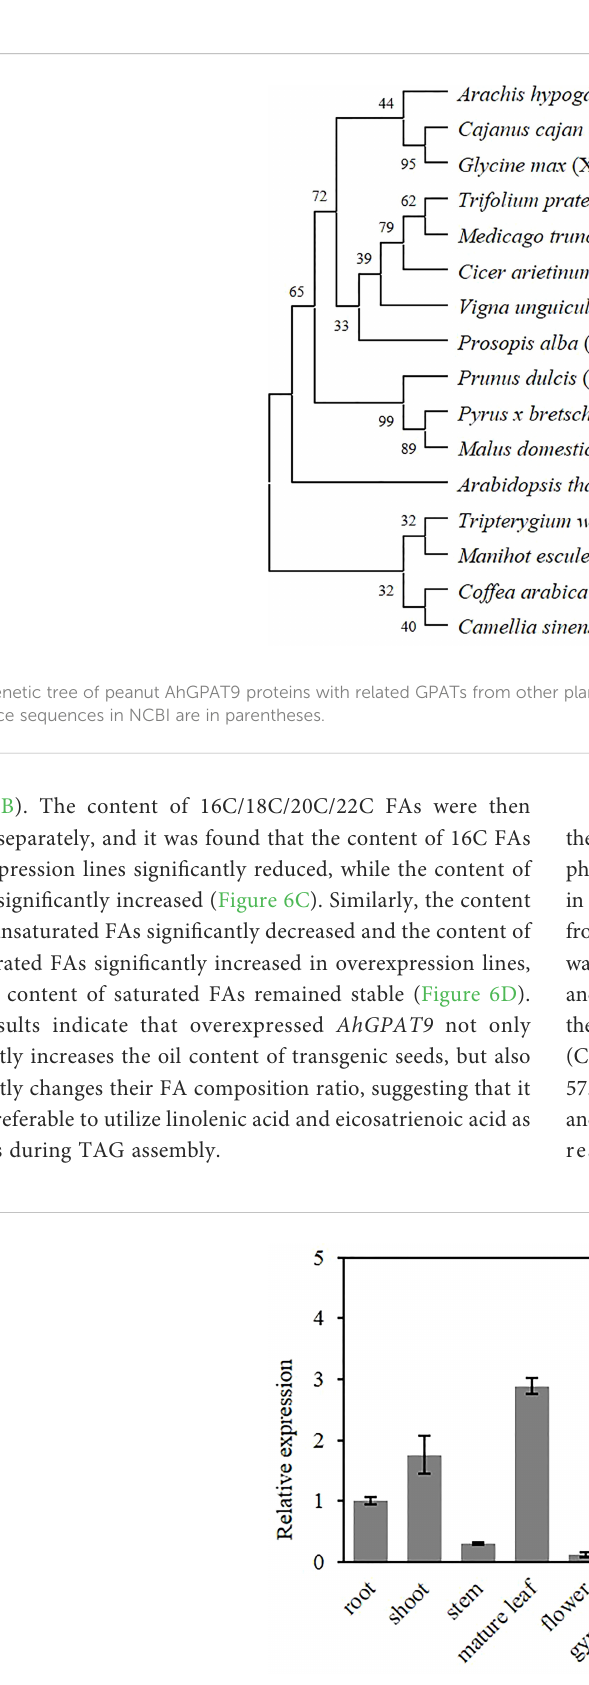
FIGURE 4 Expression analysis of AhGPAT9 using qRT-PCR in diverse tissues of peanut. The root and shoot samples were taken at seedling stage, the stem, leaf, fl ower, gynophore and seed samples were taken at adult-plant stage. Seed І , seed II, and seed Ш represent the early, middle and late stages of seed development, respectively. Relative mRNA abundance was normalized with respect to that of peanut AhACT11 , and data are shown as means ± standard deviation (n =